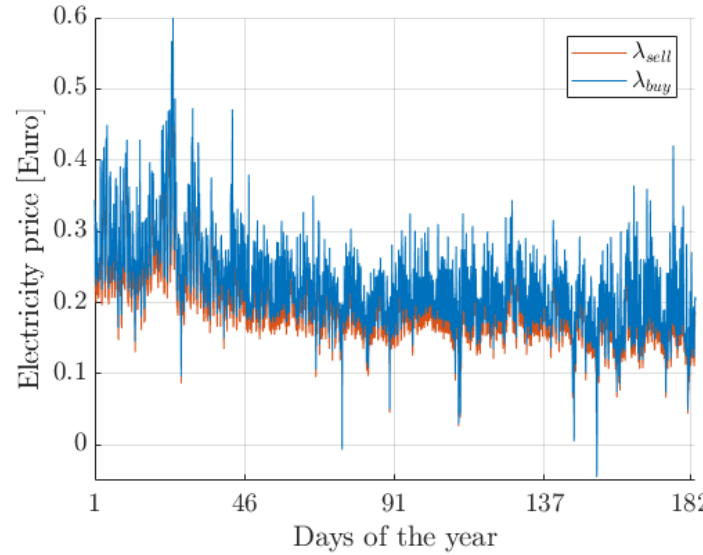
Figure 6. Electricity price based on the 2018 Amsterdam Power Exchange (APX) spot market, averaged around 0.2 e /kWh.